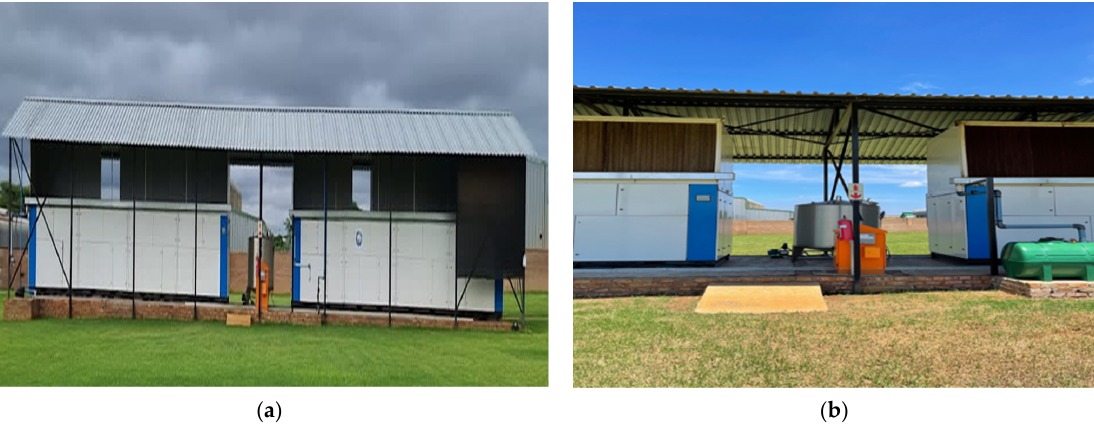
Figure 3. Operational setup of AWGs at the site of study under ( a ) pristine conditions and ( b ) modification (ECS). Table 1. Specifications and operating parameters of AWGs used in the study.